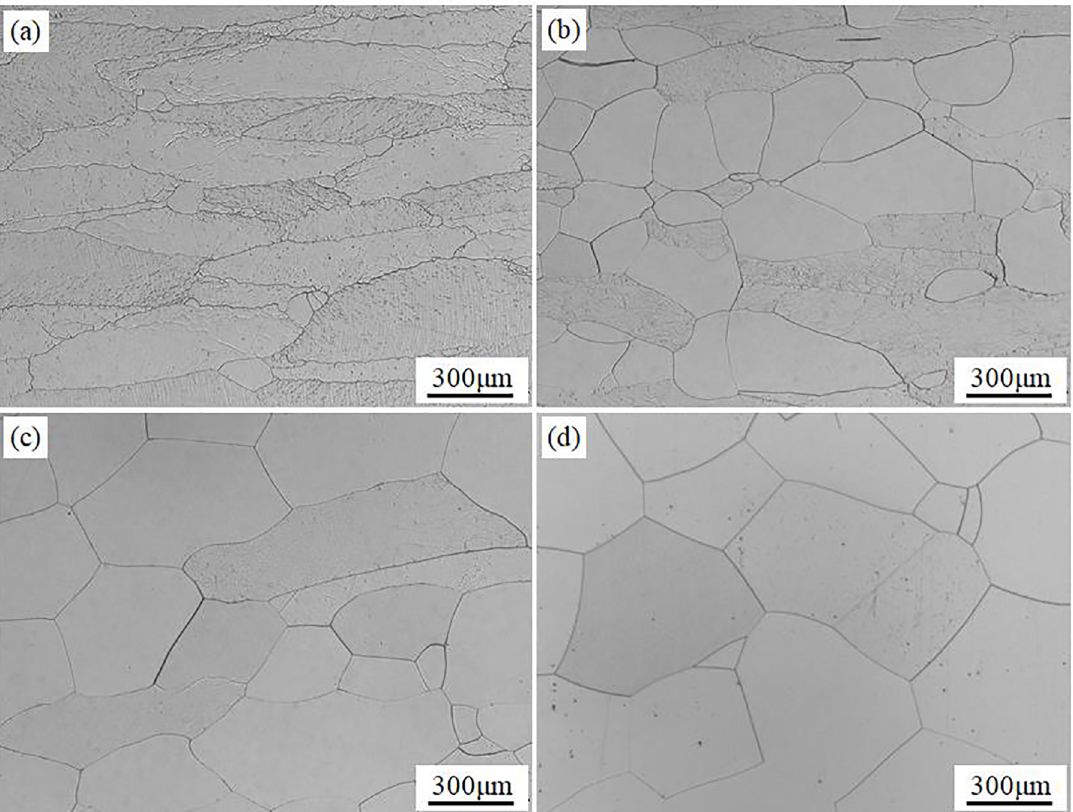
Figure 1. Microstructure of Fe-3%Si steel after deformation with the strain of 0.92 at the strain rate 30s -1 and temperature of 1323K and annealed with time (a) 1s (X